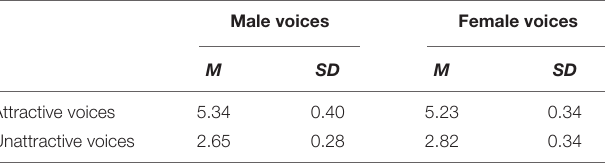
TABLE 1 | Means and standard deviations of vocal attractiveness